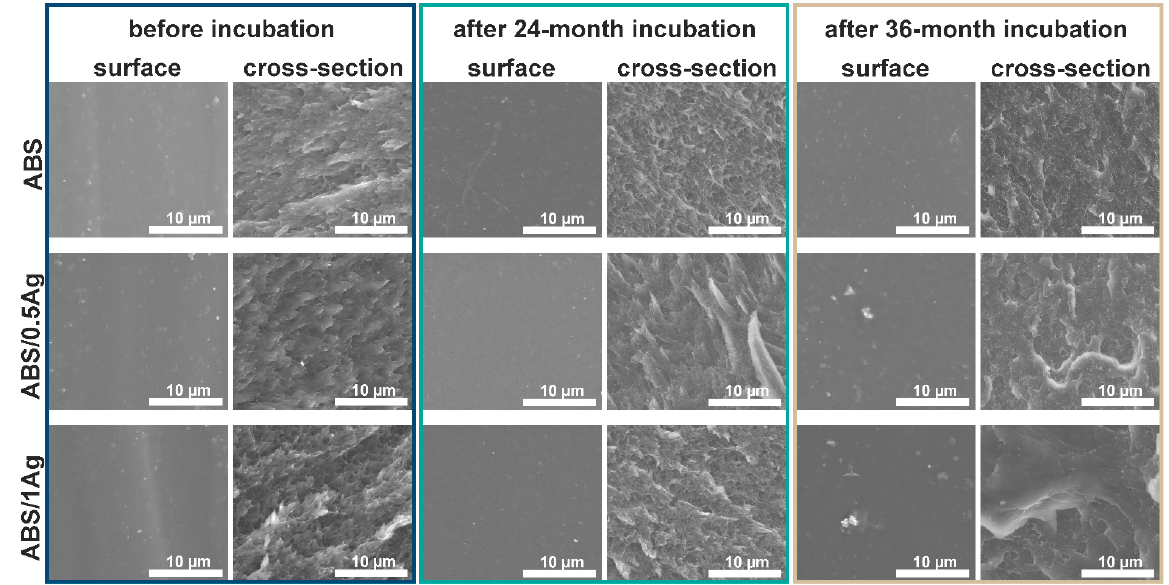
Figure 1. SEM images of the surface and cross-section of acrylonitrile butadiene styrene (ABS) and ABS-based composites modified with 0.5 wt.% and 1.0 wt.% silver nanoparticles (AgNPs) before and after the 24- and 36-month incubation periods in deionized water.